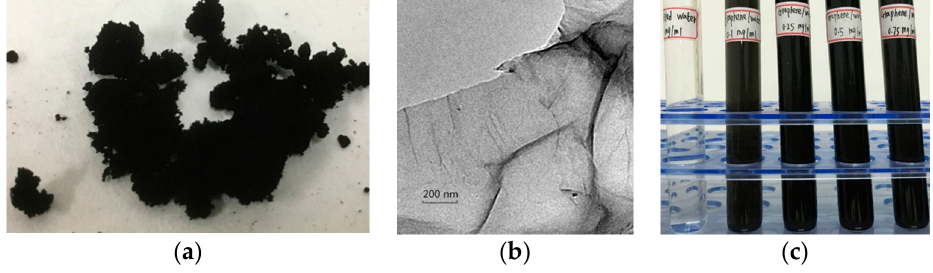
Figure 1. Photographs of graphene power and prepared graphene/water nanofluid. ( a ) Graphene powder used in the experiment. ( b ) SEM image of a graphene nanoplatelets (GNPs). ( c ) Prepared graphene/water nanofluid with different GNPs concentrations.